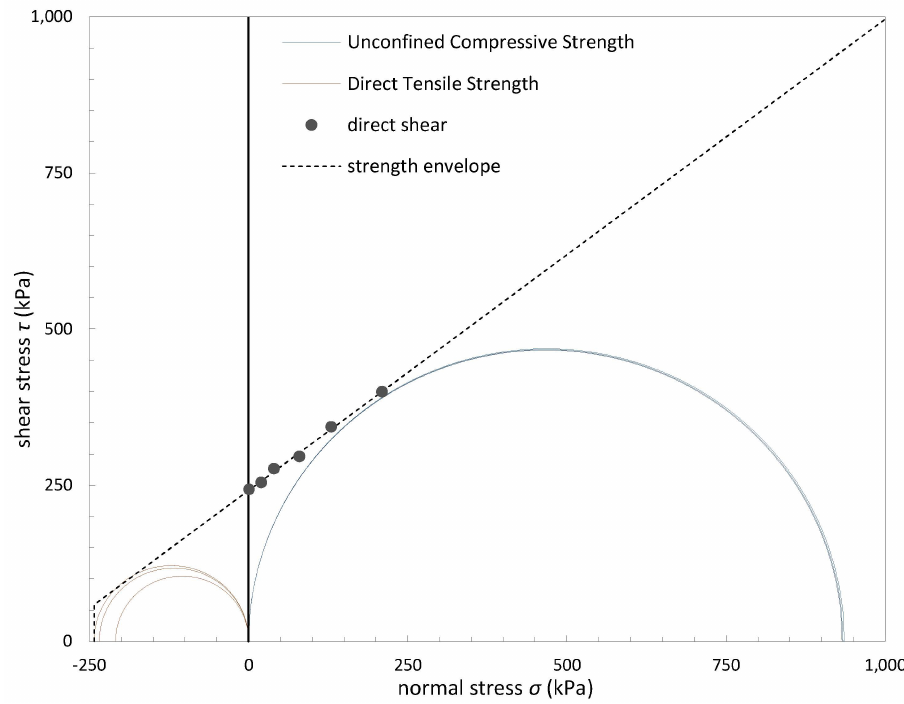
Figure 5. Mohr–Coulomb failure envelope from direct shear tests (dot markers) compared with Mohr’s failure circles for direct tension (3 tests) and unconfined compression (3 tests). Macassa CPB was tested using the same direct tension device as [30,31]. For 10% binder content and testing at 3, 7, and 14 days the strength ratios varied from m i = 5 to